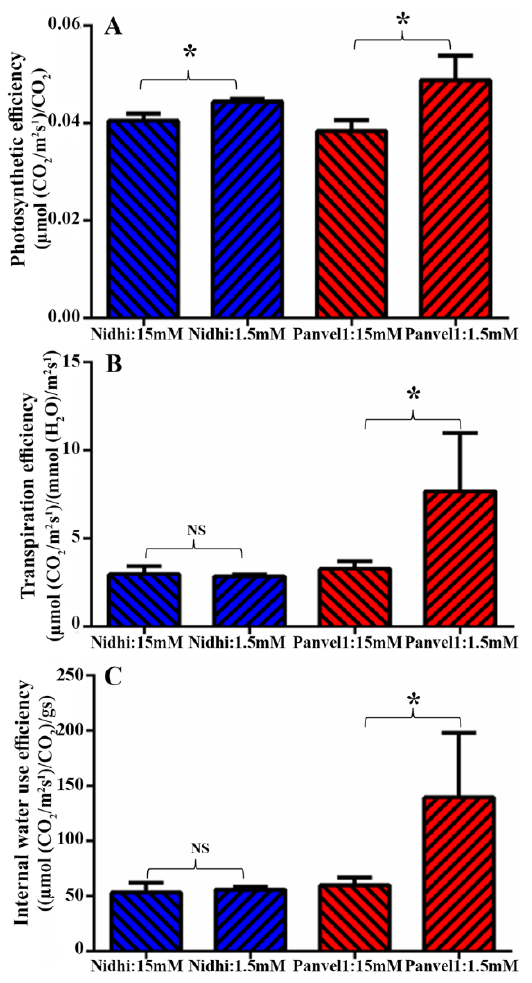
Figure 4. Validation of efficiencies derived associated with the biological processes. Validation was carried out using Licor instrument 6400XT (LI-COR, Lincoln, NE, USA) on 21 − days-old grown plants. Plants were grown in nutrient-depleted soil and fertilized with Arnon Hoagland medium having urea as sole source of N with 15 mM N concentration as control, while 1.5 mM was used as test. Measurement was carried out in four biological replicates. Efficiencies were derived from the standard formulas as described here. ( A ) Photosynthetic efficiency was measured in terms of µ mol CO 2 m − 2 s − 1 / µ mol l − 1 , ( B ) transpiration efficiency was measured in terms of µ mol CO 2 m −2 s − 1 /mmol (H 2 O)/m −2 s − 1 and ( C ) internal water use efficiency was measured in terms of µ mol CO 2 m − 2 s − 1 / mol(H 2 O) m −2 s − 1 ). The test of significance has been shown as star (* p < 0.05) between the bars of low urea and normal urea, while NS represents non-significance.